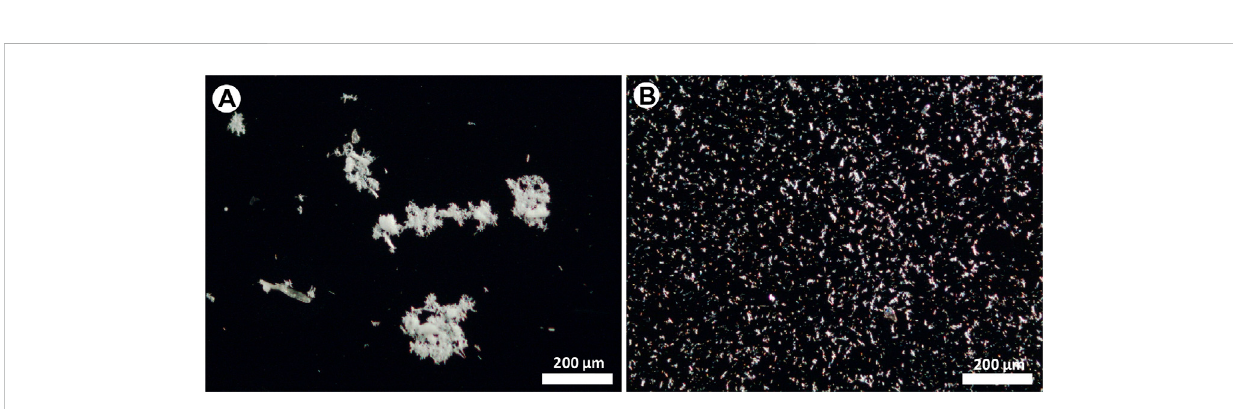
FIGURE 4 Optical images of the asbestos depositions obtained with (A) the pipette (drop) and (B) the micro-drop methods, respectively. Optical images taken with ×10 objective